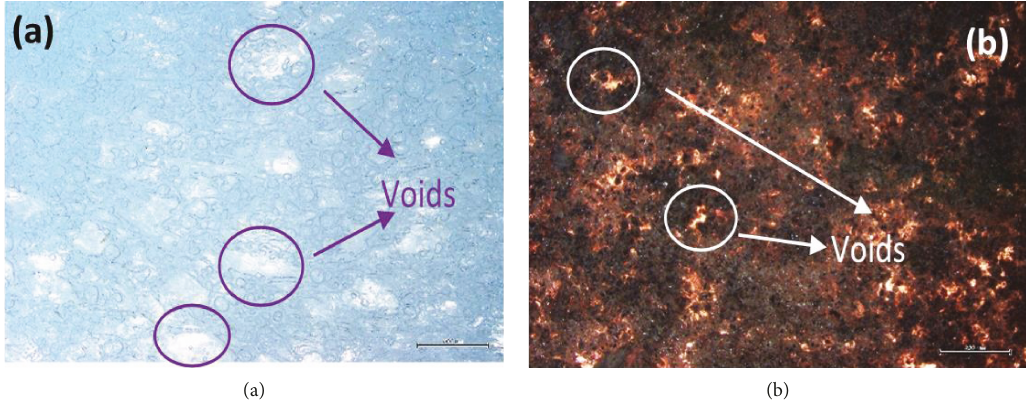
Figure 6: Optical microscope image for (a) pure polystyrene and (b) 20-DPP composite sample.